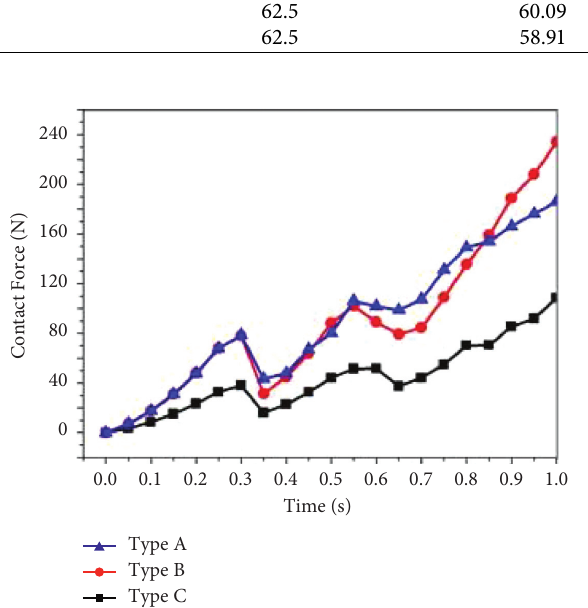
Figure 9: Contact force-time history curve of steel ball.